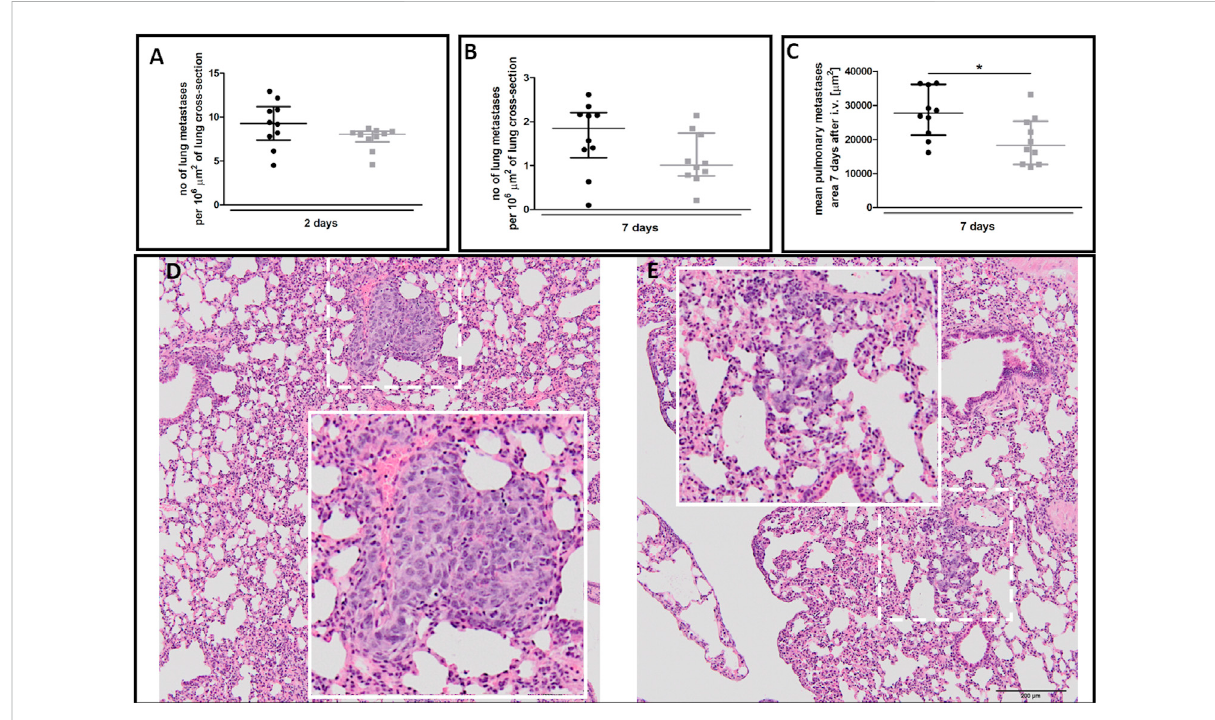
FIGURE 9 Pulmonarymetastasisin20-week-oldand40-week-oldBALB/cmice.Blacksymbolsdenote20-week-oldmice,andgreysymbolsdenote40- week-old mice. The number of pulmonary metastases (A) two and (B) seven days post-injection of 4T1 breast cancer cells ( n = 9 – 10). (C) The mean area of pulmonary metastases seven days post-injection of 4T1 breast cancer cells ( n = 10). The morphology of pulmonary nodules in (D) 20-week- old and (E) 40-week-old mice seven days post-injection of 4T1 breast cancer cells where the dotted line demarks the area visually enlarged, indicated by the solid line. Data are shown as median and IQR and were compared with a non-parametric Mann-Whitney test (A,B) or an unpaired two-sided Student ’ s t -test (C) . Key: * p <